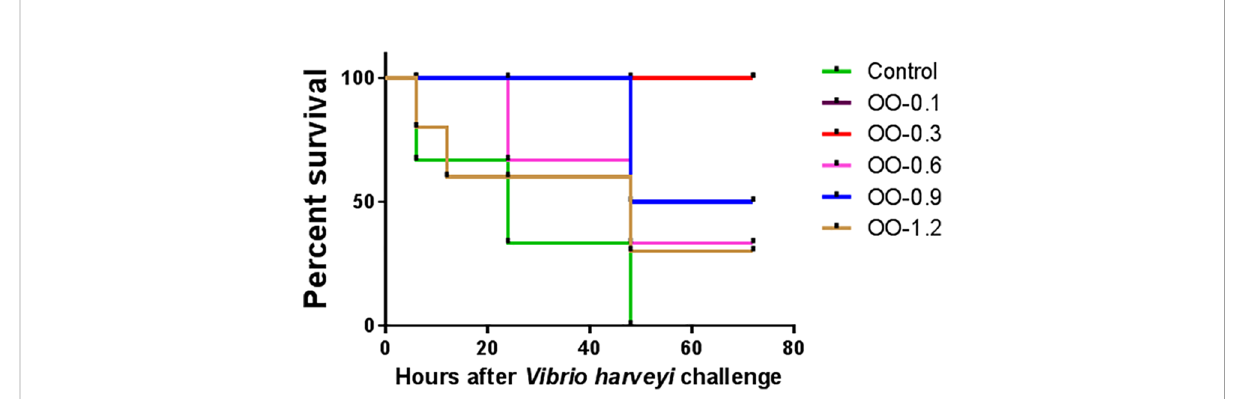
FIGURE 1 Effect of dietary oregano oil (OO) on cumulative mortality of juvenile hybrid grouper fed the experimental diets for 8 weeks after the Vibrio harveyi